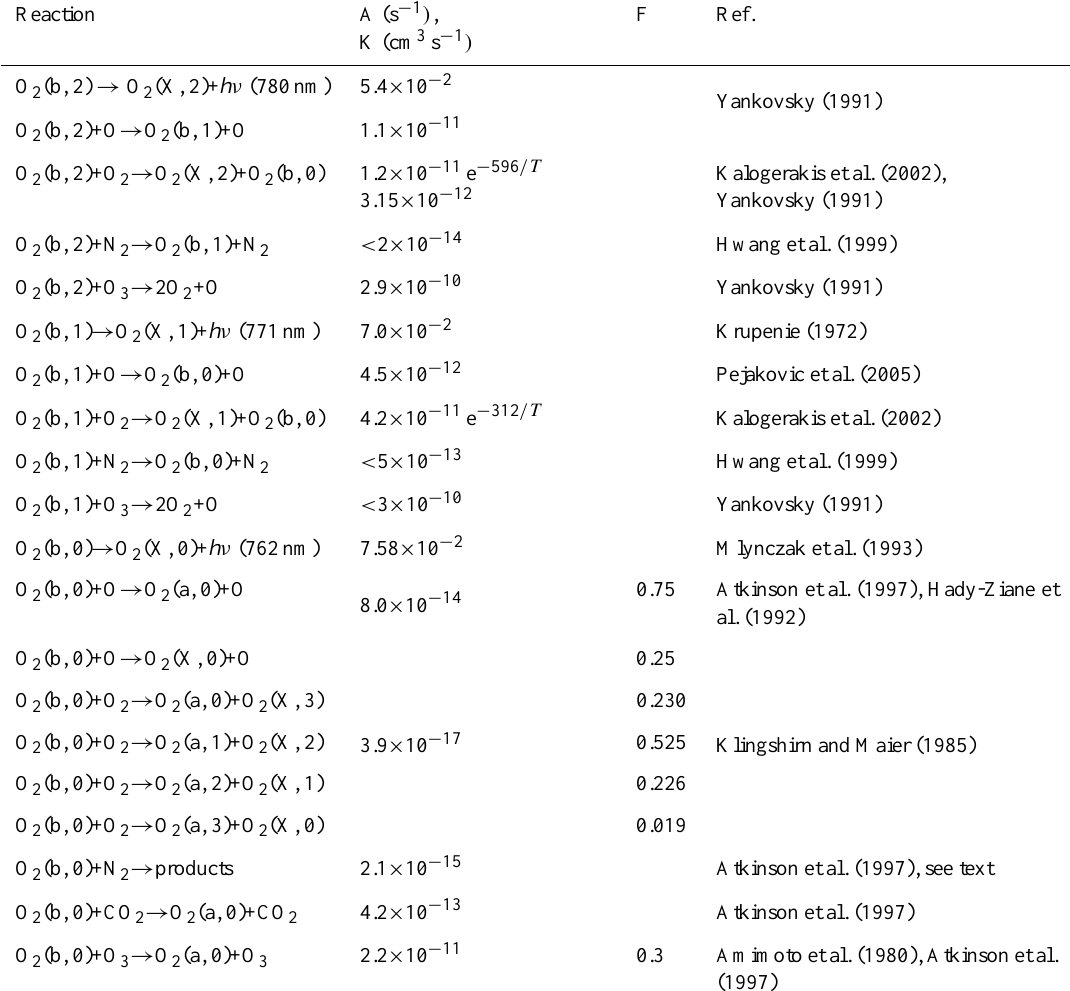
Table 3. Processes of deactivation of O 2 (b 1 6 + g , v). Symbols as in Tables 1 and 2.